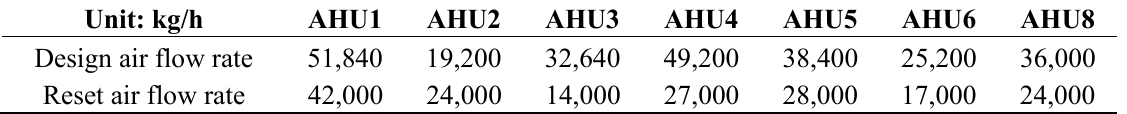
Figure 4. Existing operation condition of a room indoor temperature graph (Case 1-1): ( a ) design air flow rate set point; ( b ) reset of air flow rate set point. Table 5. Reset the air handling unit (AHU) fan air flow